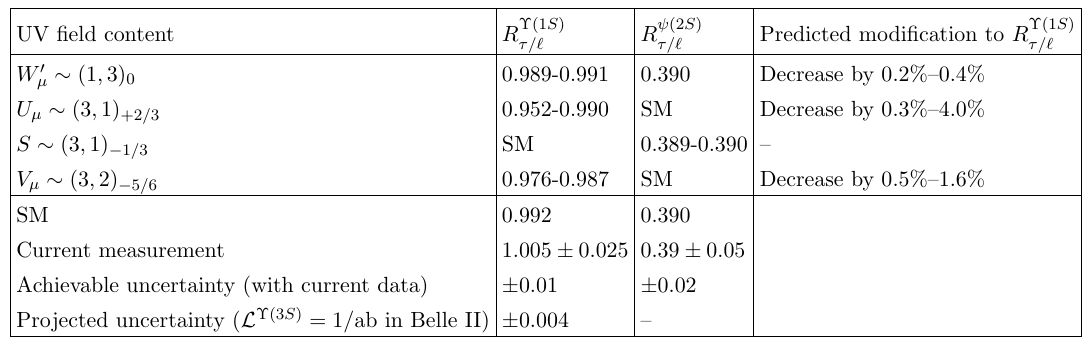
Table 3. The simpli(cid:12)ed (single boson) models and the predicted range for R V V = (cid:7)(1 S ) ; (2 S ). The achievable and projected uncertainties are our estimations, see the text for more